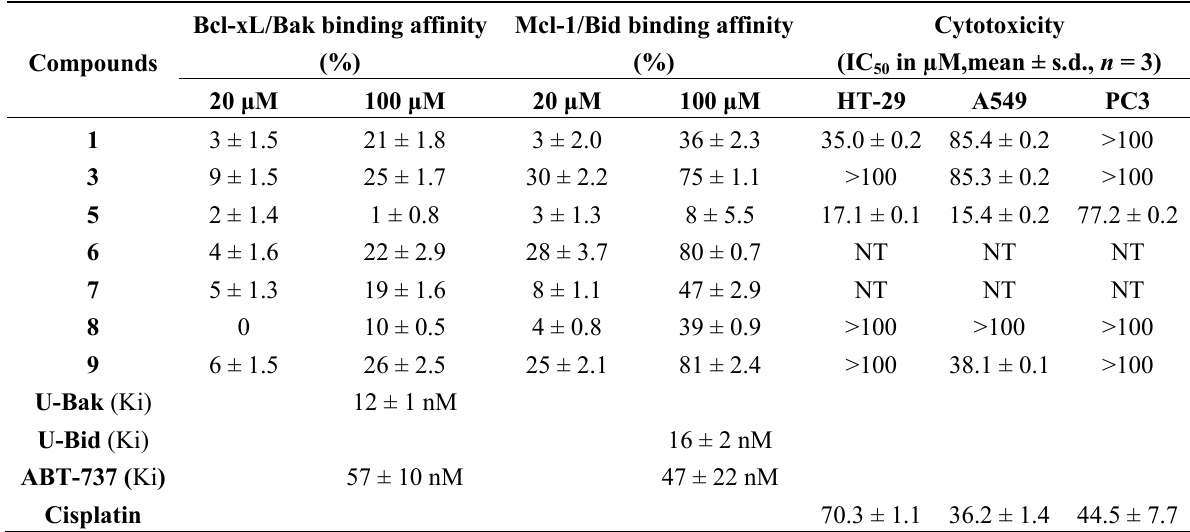
Table 4. Biological activities of compounds 1 , 3 , 5 – 9